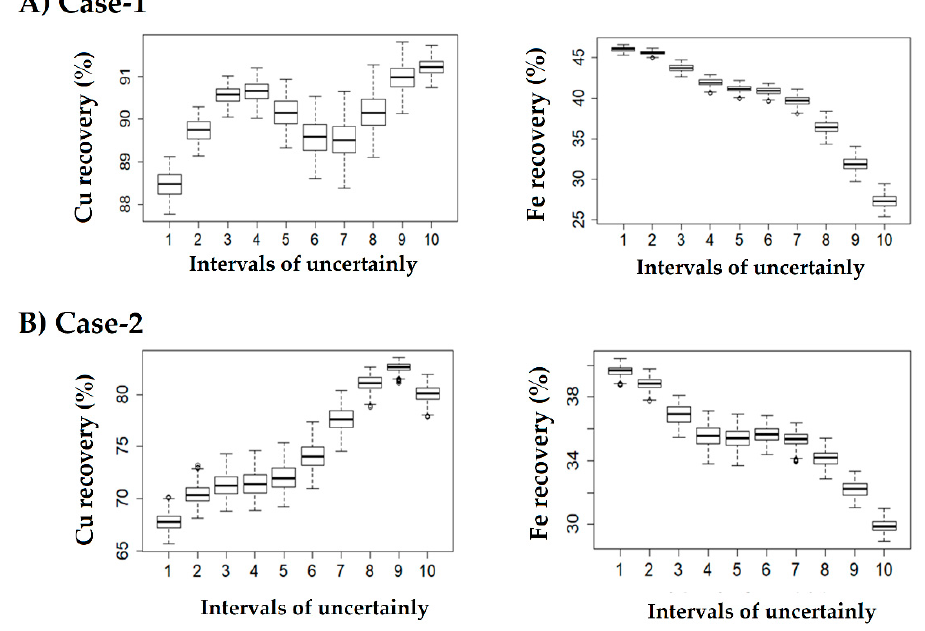
Figure 3. Uncertainty analysis of neural metamodel for copper and iron recoveries.